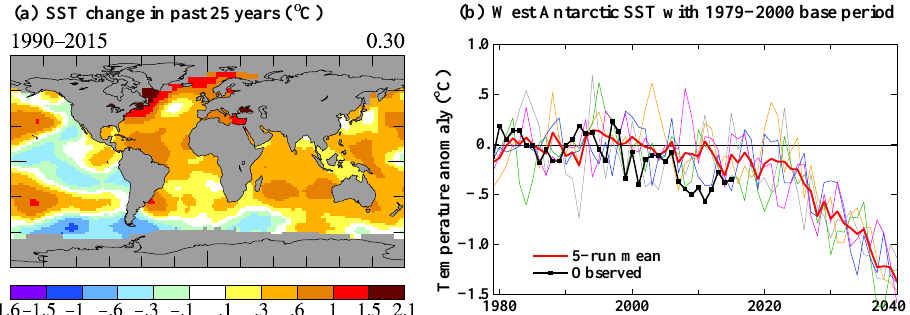
Figure 31. (a) Observed 1990–2015 SST change based on local linear trends and (b) SST anomaly relative to 1979–2000 for area south of 56 ◦ S between the dateline and 50 ◦ W. Base period excludes data prior to 1979 to avoid use of Southern Ocean climatology that artificially reduces variability (Huang et al., 2015).